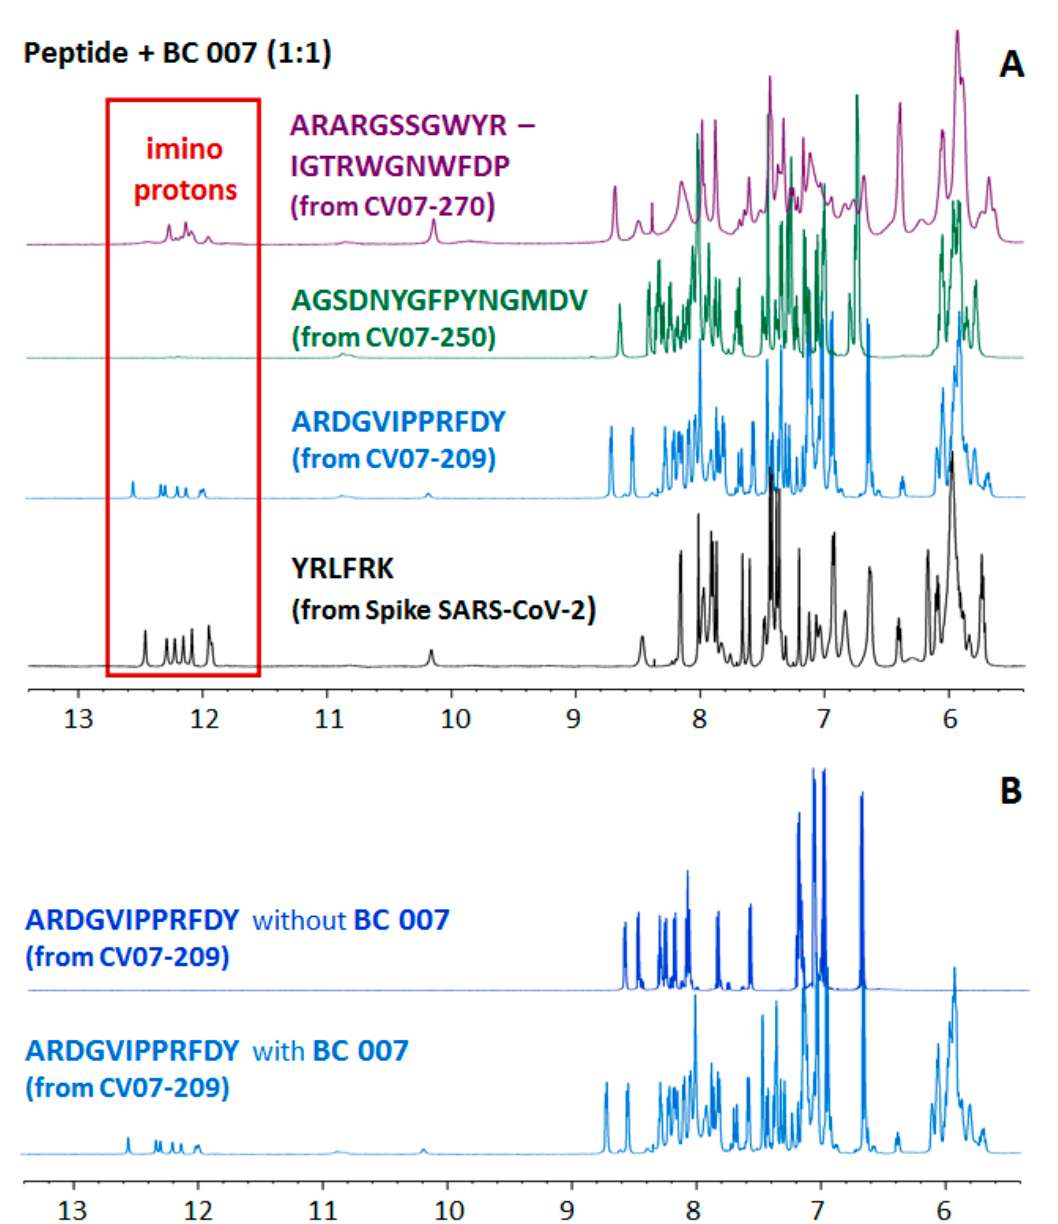
Figure 1. NMR spectroscopic evaluation of the molecular interaction of BC 007 with published CDR-H3 sequences of the anti-SARS-CoV-2 mABs of patients. ( A ) Upper spectrum (purple): The upper NMR spectrum of BC 007 (1 mM) in combination with ARARGSSGWYRIGTRWGNWFDP (published CDR-H3 of CV07-270 [21]) (1:1) shows BC 007-folding-specific imino signals in the range of 11.5–12.5 ppm. Second from top (green): The spectrum of 1 mM BC 007 in the presence of 1 mM AGSDNYGFPYNGMDV (published CDR-H3 of CV07-250 [21]) does not show any folding of BC 007, excluding any binding or molecular interactions. Third from top (blue): Here, 1 mM ARDGVIPPRFDY (published CDR-H3 of CV07-209 [21]) showed a very small amount of quadruplex-specific imino signals between 11.5 and 12.5 ppm. Bottom spectrum (black): For comparison of the visualization of the quadruplex signal as binding and folding success: SARS-CoV-2 spike protein occurring sequence YRLFRK-caused fold of BC 007 as discussed before in detail by Weisshoff et al. [1]. ( B ) Upper spectrum: Peptide sequence of the published CDR-H3 region of CV07-209 (ARDGVIPPRFDY, 1 mM) alone. Lower spec- trum: Here, 1 mM ARDGVIPPRFDY in the presence of 1 mM BC 007 does not show significant shifts in the aromatic protons of Phe and Tyr. Charge-, pH-, and ionic strength-dependent amide protons of all amino acids are showing only small changes in the chemical shift but not in the coupling constants, again excluding any strong interaction of the CDR- H3 region of CV07-209 with BC 007.